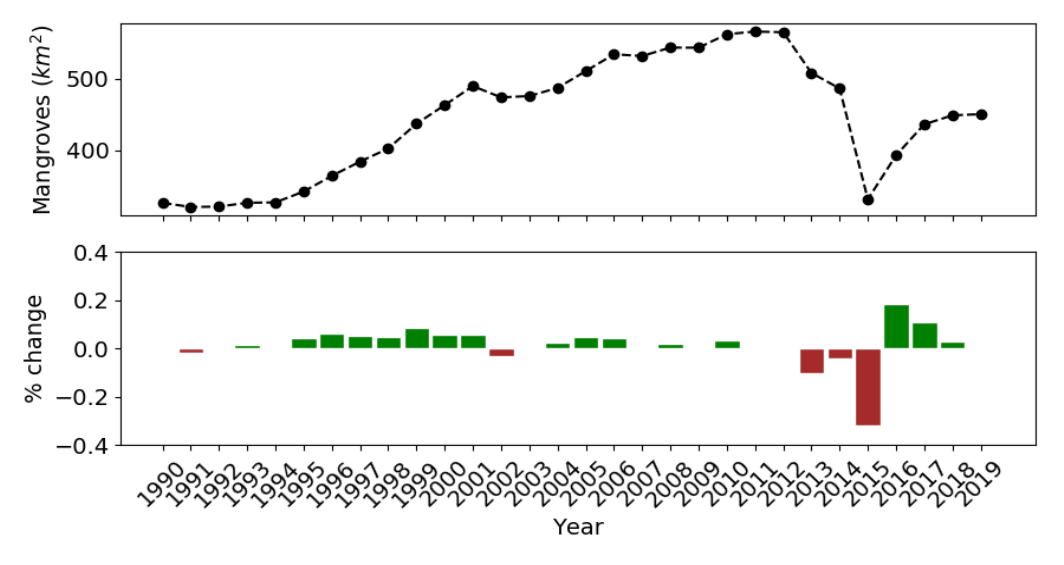
Figure 13. Mangrove extent over time for the Gulf of Carpentaria, north